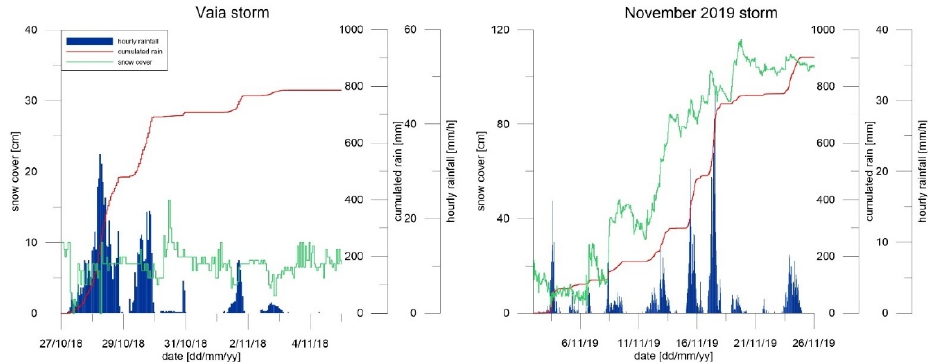
Figure 2. Daily rainfall, cumulated rainfall,